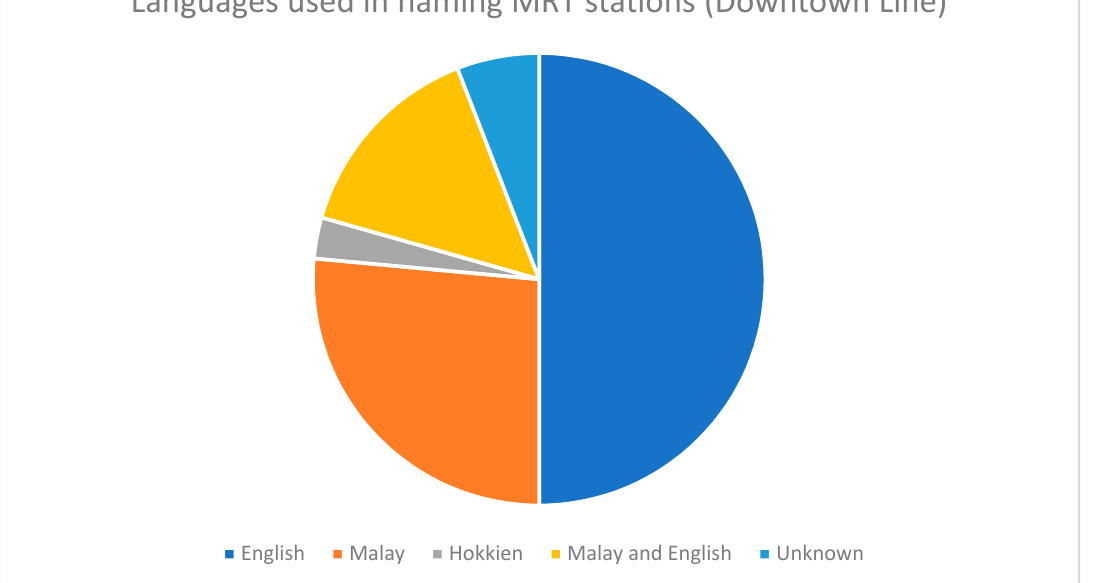
Figure 2. Languages used in naming the MRT stations on the Downtown Line.